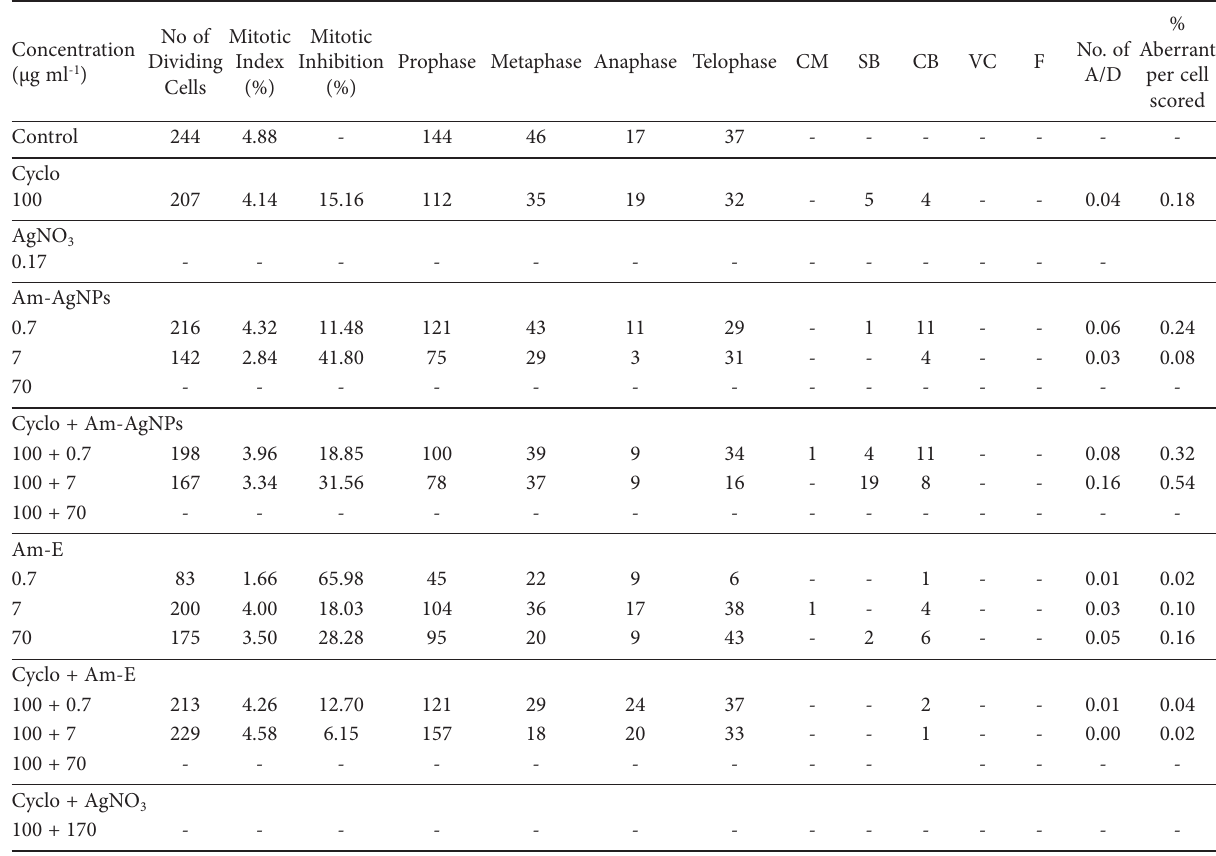
Table 5. Cytogenotoxic Eff ect of A. muricata Extract-Mediated Silver Nanoparticles on Allium cepa root meristerimatic cells at 72 h com- pared with control (positive and negative)